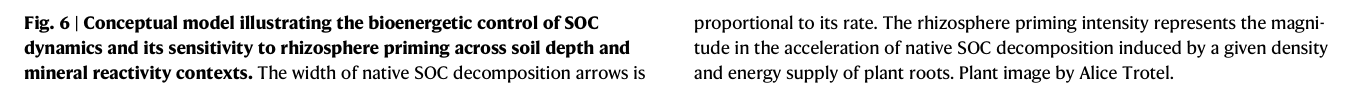
Fig. 6 | Conceptual model illustrating the bioenergetic control of SOC dynamics and its sensitivity to rhizosphere priming across soil depth and mineral reactivity contexts. The width of native SOC decomposition arrows is